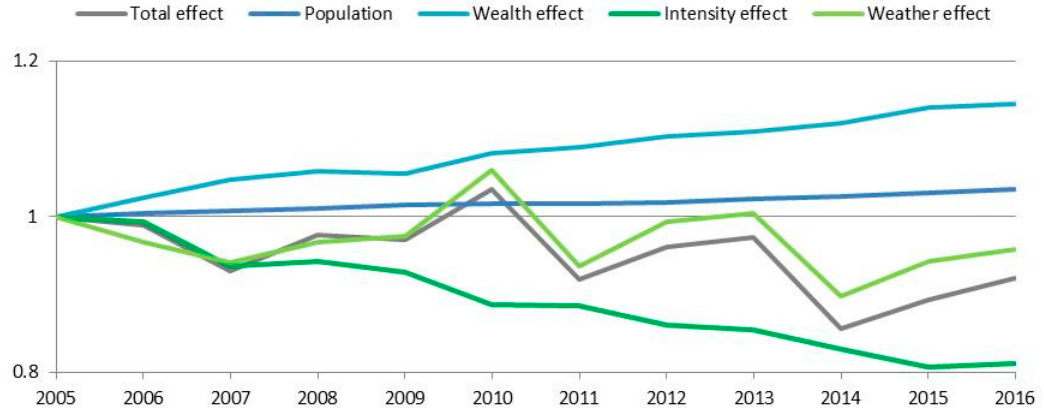
Figure 20. Multiplicative results of decomposition of EU-28 residential energy consumption in 2005–2016.